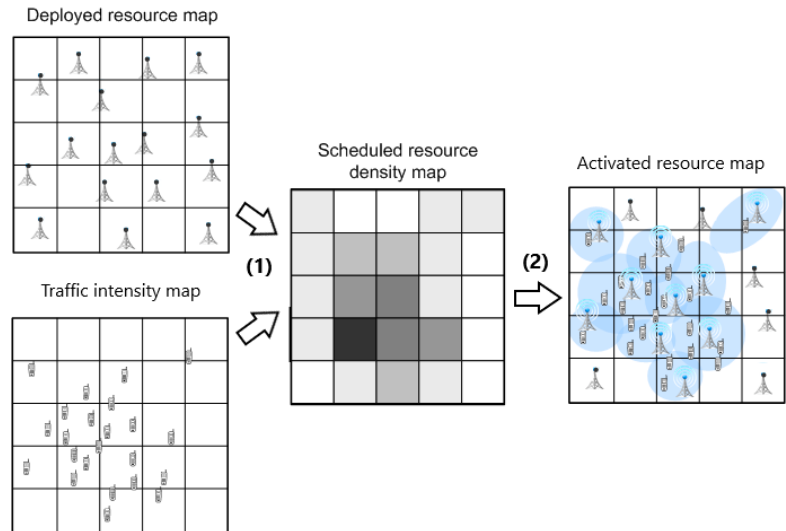
Figure 1. Illustration of logical steps of a network scheduling algorithm in ultra-dense networks (UDNs): ( 1 ) a first step determines the density of the scheduled access nodes (ANs) in a region i.e., how many ANs should be active in the region; ( 2 ) a second step determines which of the deployed ANs should be activated based on said network scheduled density.